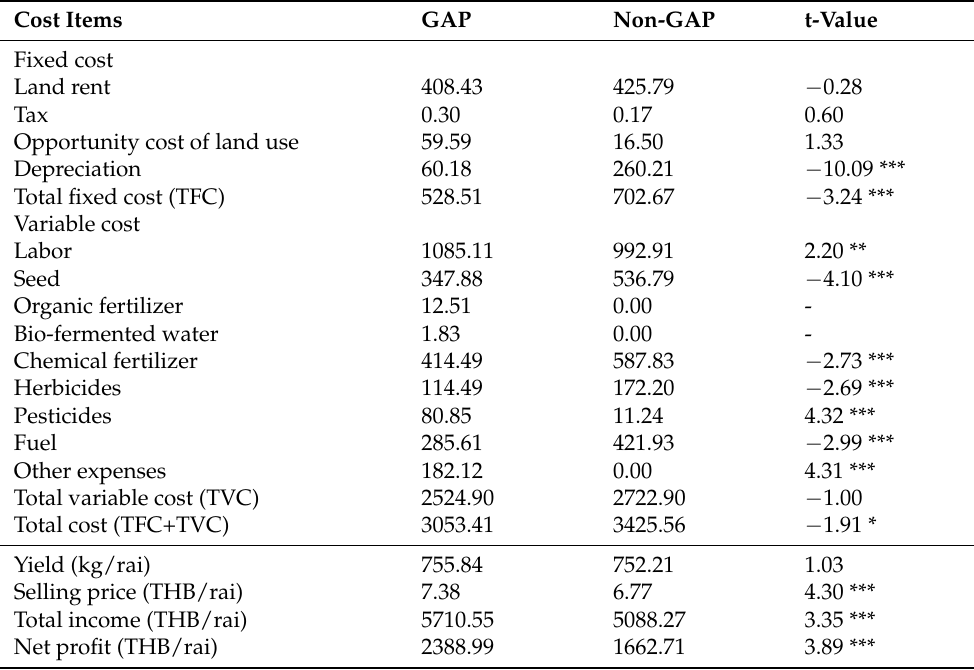
Table 2. Cost and return of rice production by GAP and non-GAP